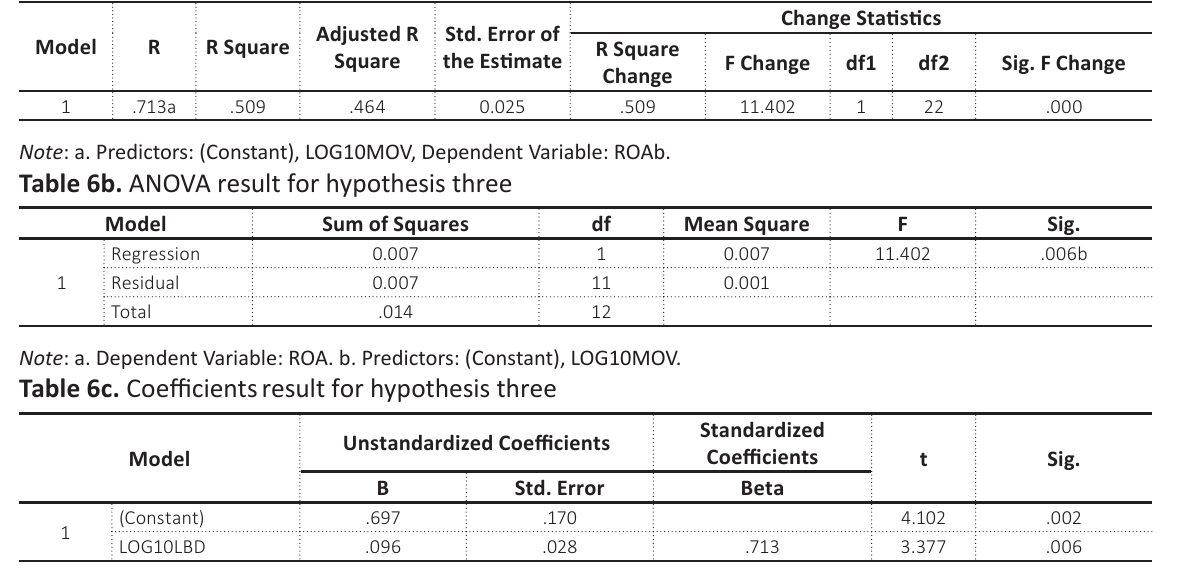
Table 6a. Model summary for hypothesis three